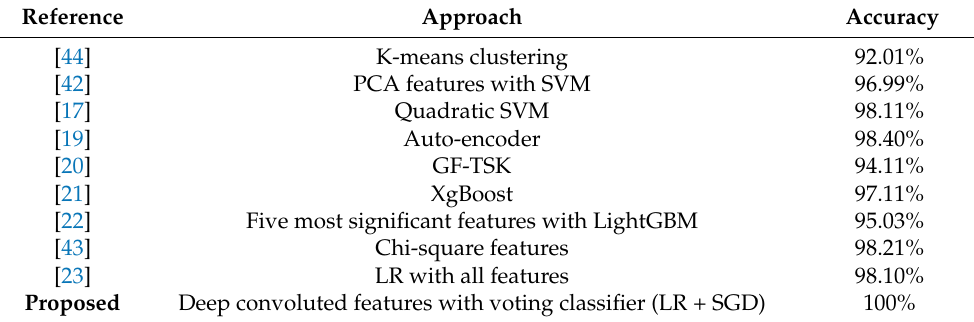
Table 7. Performance comparison with state-of-the-art studies.